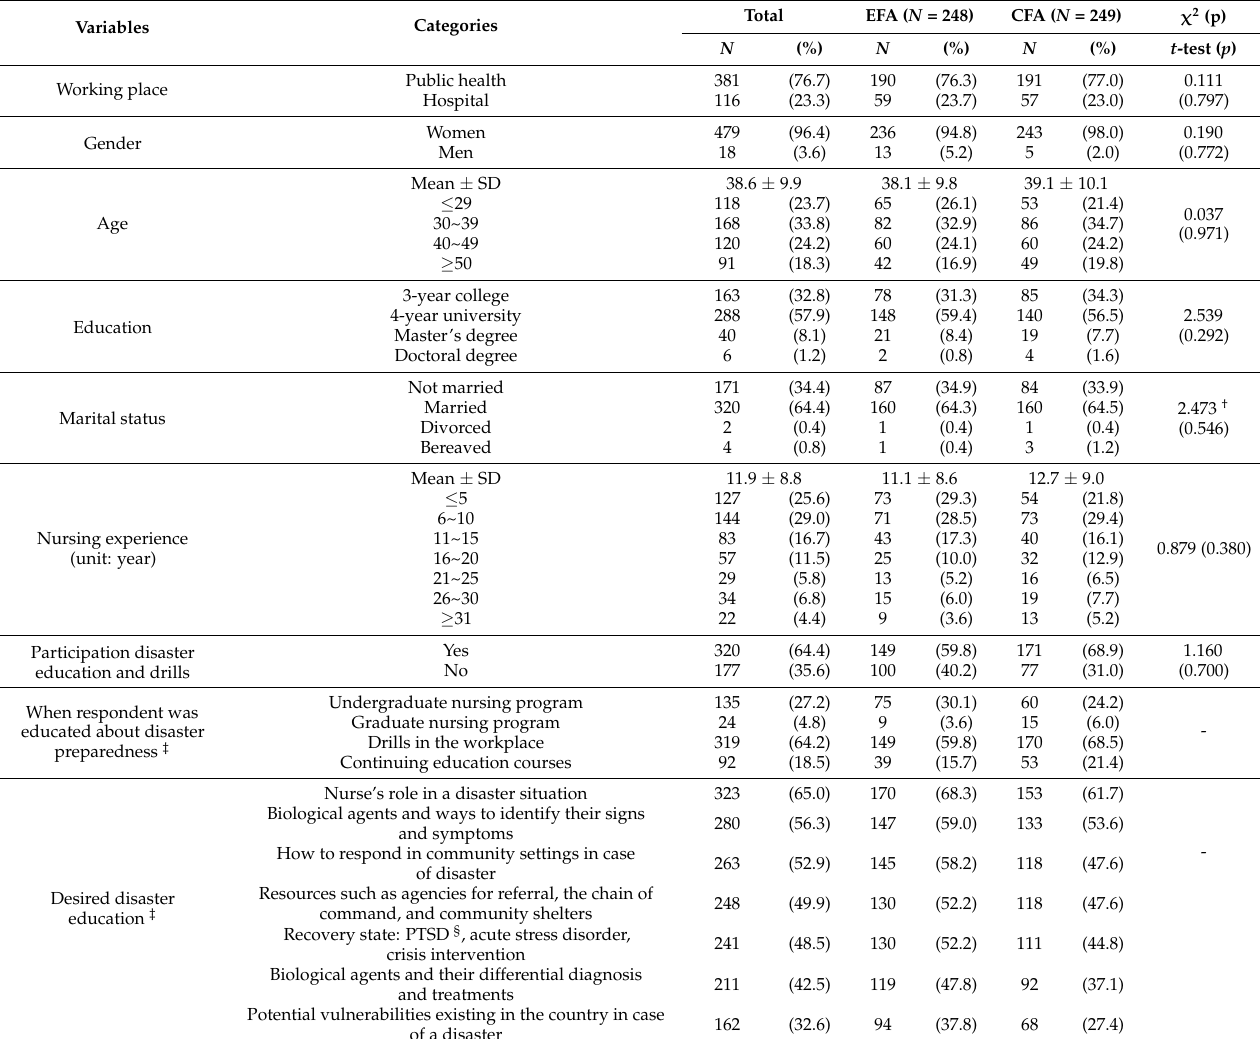
Table 1. General characteristics of participants ( N =